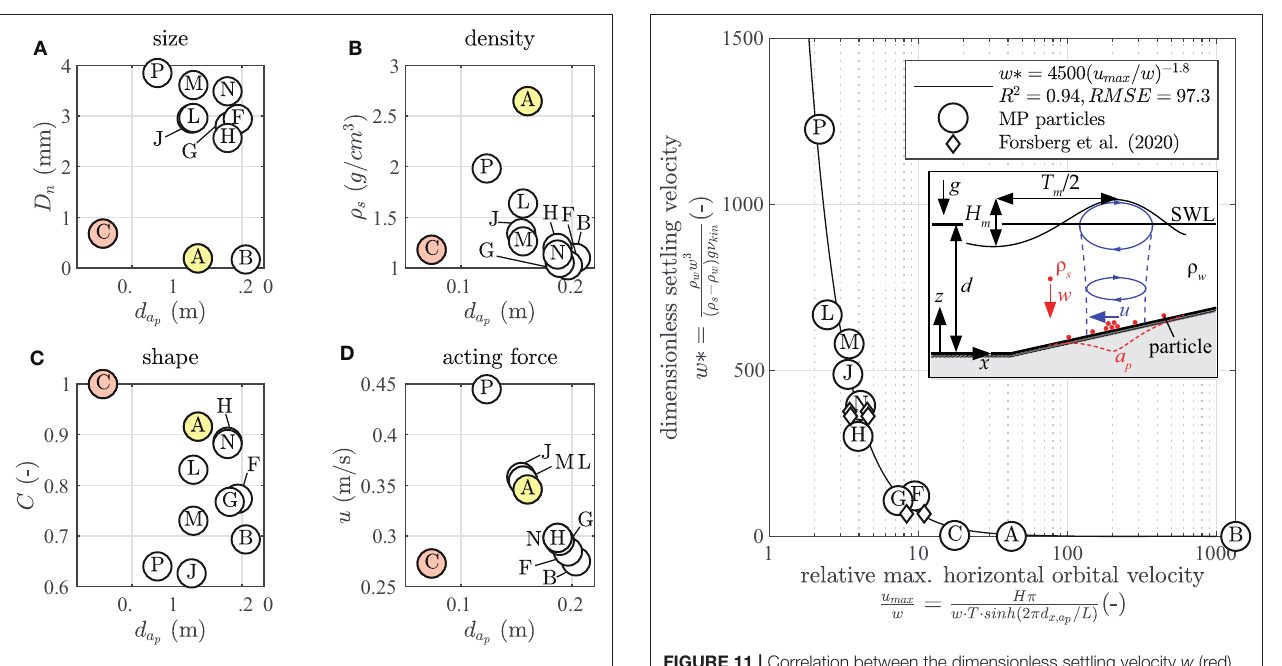
orbital velocity u max is induced by the prevalent wave climate and represents the acting forces of the fluid motion on the particle on the bed profile and includes the mean wave height H m , mean wave period T m and the local water depth d z , a p